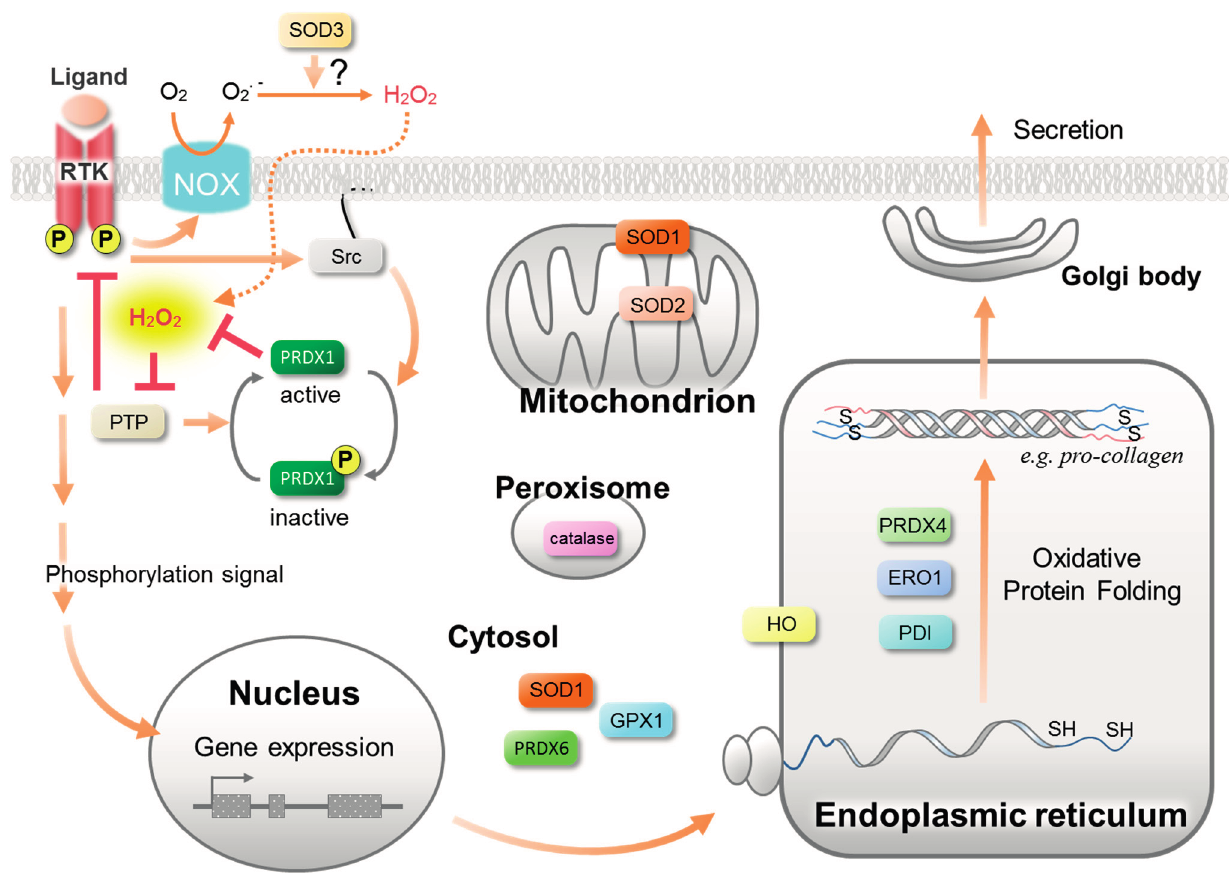
Figure 2. Isoforms and the predominant subcellular localization of antioxidative enzymes. Antioxidative enzymes and their isoforms constitute a cellular defense system against oxidative stress at the corresponding subcellular positions. At the same time, they permit the low concentrations of ROS to equilibrate, serving as signaling pathways to regulate the wound healing processes. For example, PRDX1 is involved in the growth factor-mediated phosphorylation signaling pathway and PRDX4 is involved in oxidative protein folding (See the text for